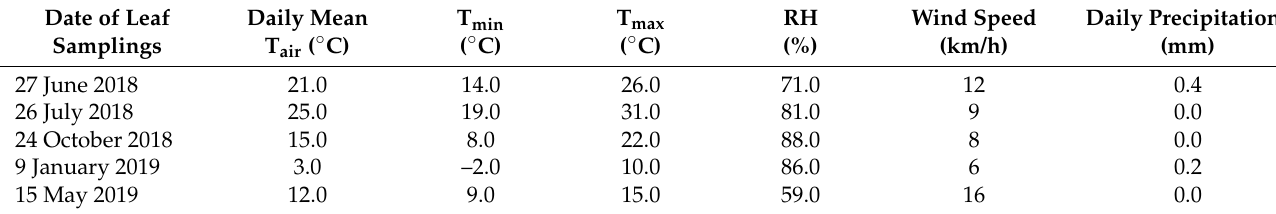
Table 2. Daily temperatures on leaf sampling dates during the experimental period (27 June 2018–15 May 2019). Meteorological data recorded with automatic weather station: mean daily air temperature (T air ); maximum (T max ) and minimum (T min ) daily air temperatures; mean daily relative humidity (RH), wind speed and daily precipitations